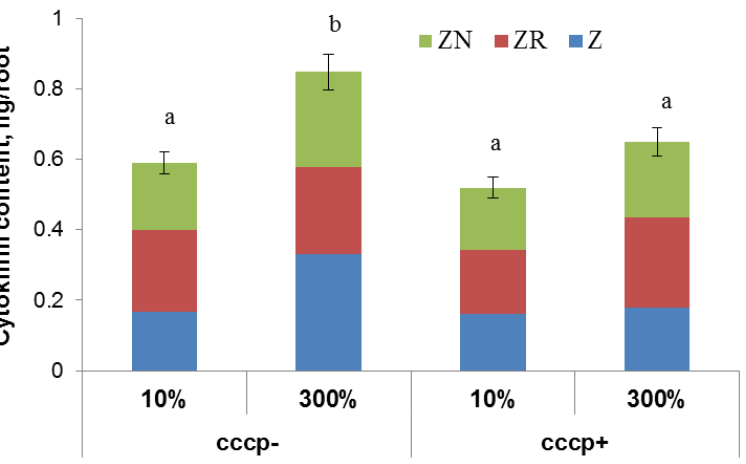
Figure 4. Total concentration of zeatin (Z), zeatin riboside (ZR), and zeatin nucleotide (ZN) in roots of 6-day-old barley wild type (Steptoe) growing at 10% of supra-optimal (300%) Hoagland-Arnon solution (H-A) 1 h after treatment with carbonyl cyanide m-chlorophenyl hydrazone (cccp). Means ± SE are presented. Statistically different means (n = 9) are indicated by different letters ( p < 0.05, ANOVA, Duncan’s test).